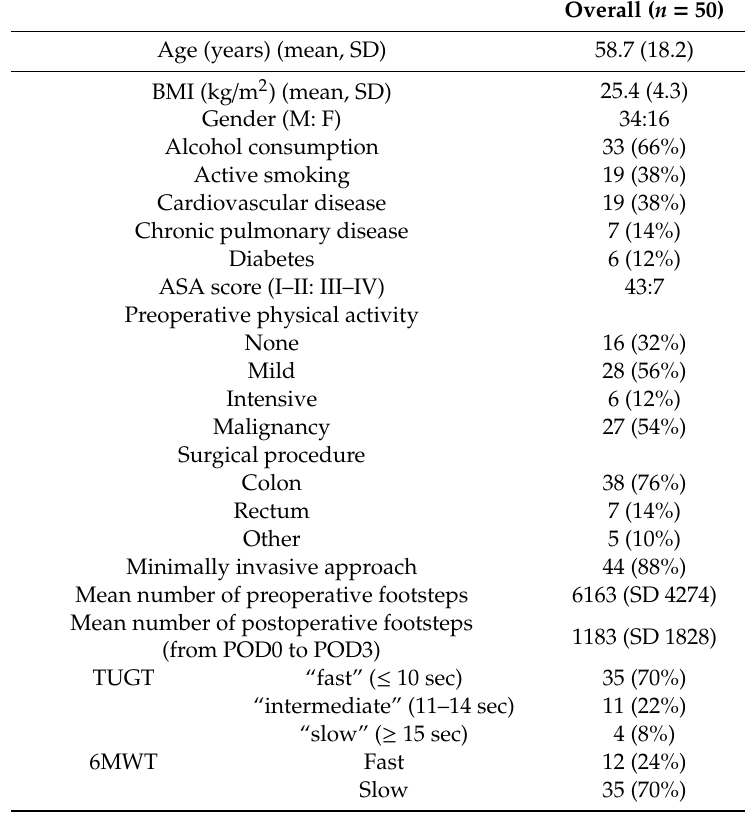
Table 1. Patient demographics, surgical details, and physical